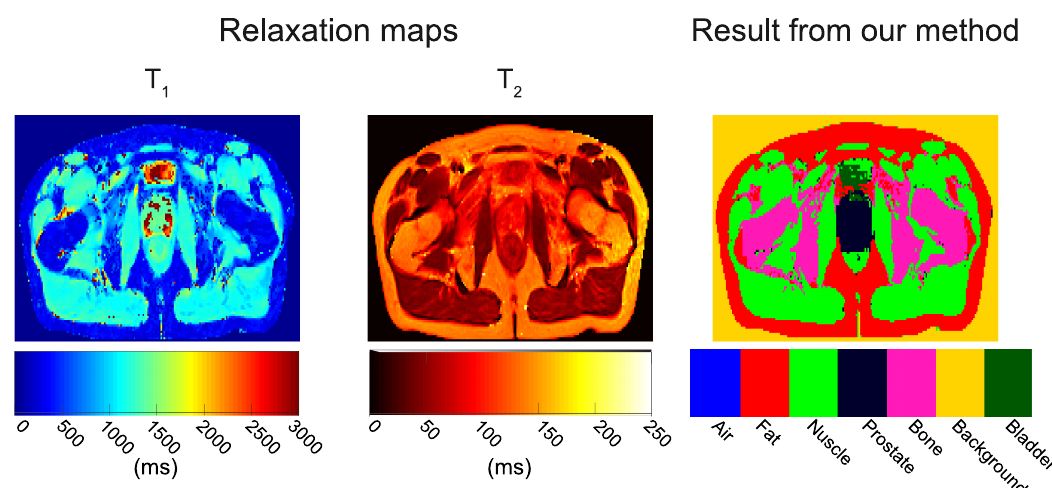
Fig 8. Relaxation maps and classification results of volunteer 20. The T 1 relaxation map shows heterogeneous values for the bladder and prostate areas, and homogeneous non-distinctive areas for fat and bone marrow which complicate the classification process. The T 2 map only shows two discernible areas: 1) fat-bone marrow-prostate-bladder ( � 100ms) and 2) muscle ( < 100 ms) adding additional complexity to the classification process. Nevertheless, the SVM classifies accurately labeled the different areas: prostate = 89.1%, fat = 100%, muscle = 98.8%, bone marrow = 89.7%, bladder = 71.9% and air was not present. All features were used to perform the classification.